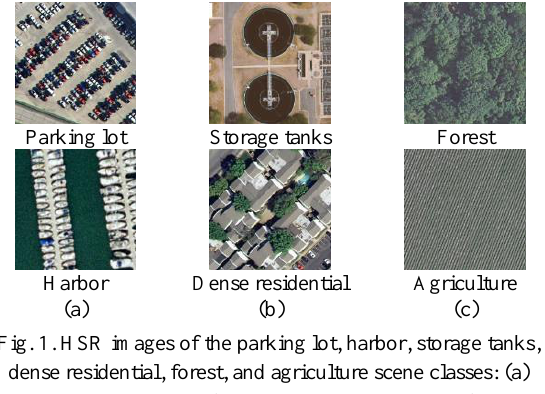
Fig. 1. HSR images of the parking lot, harbor, storage tanks, dense residential, forest, and agriculture scene classes: (a) shows the importance of the spectral characteristics for HSR images; (b) shows the importance of the structural characteristics for HSR images; and (c) shows the importance of the textural characteristics for HSR